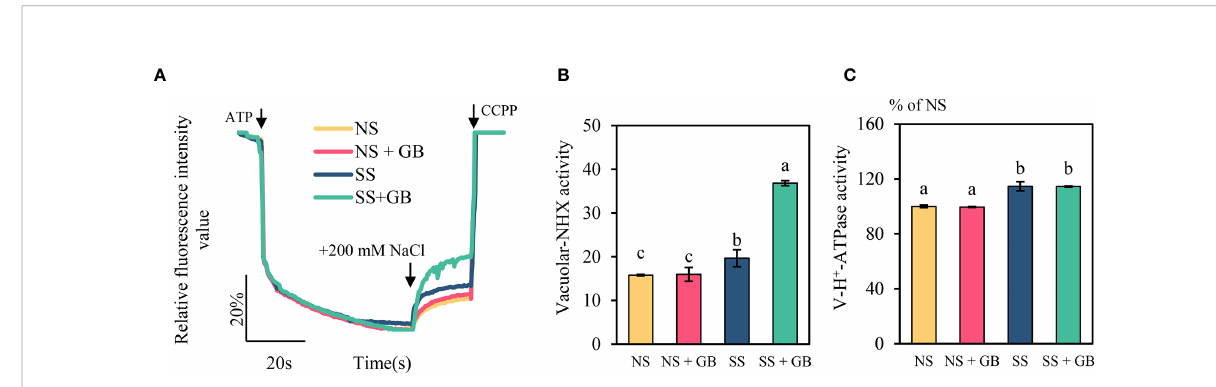
FIGURE 5 Effects of GB on the activity of vacuolar H + -ATPase and NHX. (A) Activity of vacuolar Na + /H + antiporters, (B) mean rate of Na + /H + antiporter activity over the duration of measurement, and (C) H + -ATPase activity. The values indicate the mean, while the vertical error bars indicate the standard deviation (n = 5). The different letters in each panel indicate signi fi cant differences determined with Fisher ’ s protected LSD test at P <